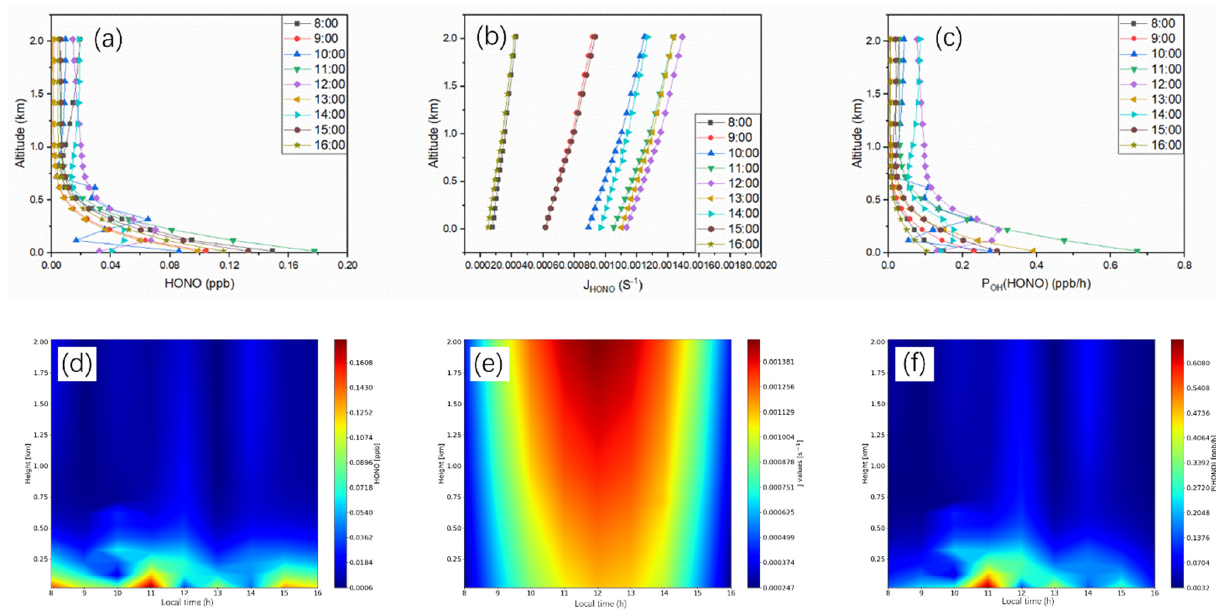
Figure 12. Case analysis of OH production rate from HONO photolysis for a clear day (11 January 2018). ( a – c ) is the correlation between [HONO], J HONO , P OH , and altitude at different times in one day. Different colored lines represent different times. ( d – f ) is the profile of [HONO], J HONO , and P OH respectively.